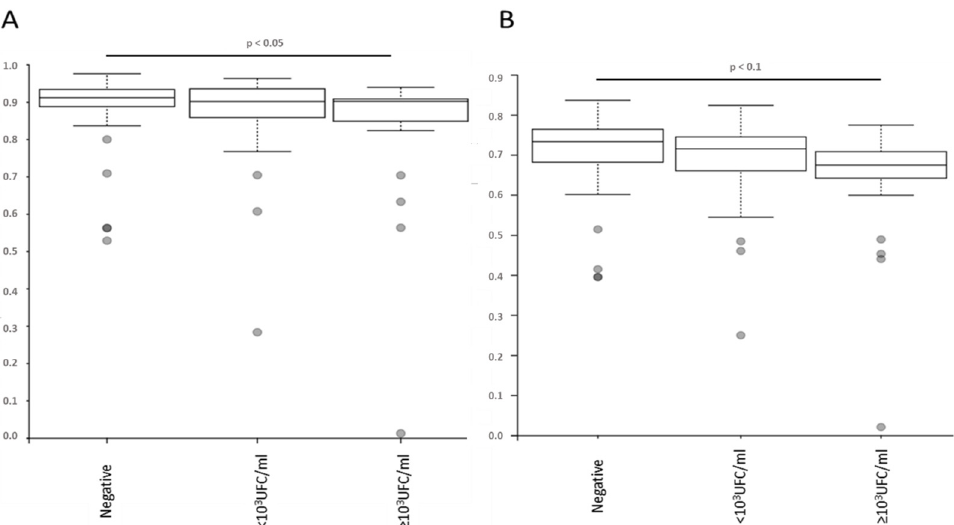
Figure 1. Comparison of alpha-diversities, determined with different indexes (( A ) Simpson; ( B ) Pielou) according to the results of the PVC culture. The box plots represent the mean and interquartile range for each index, and the vertical axis is the respective index value.